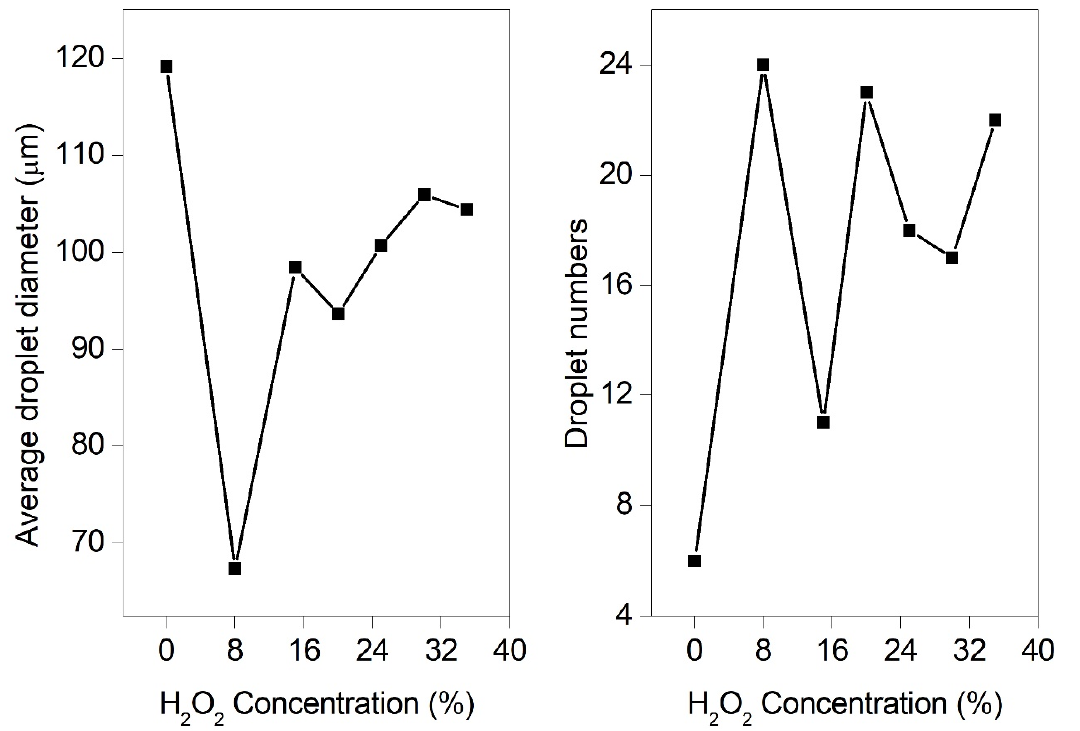
Figure 13. The average droplet diameters and the numbers of breakup droplets at different H 2 O 2 concentrations (21G nozzle, flow rate of 500 mL/h, voltage of 28 kV).